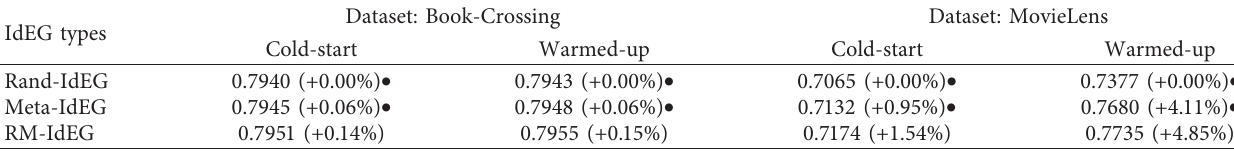
Table 5: Testing AUC comparison of different IdEGs on synthetic datasets.